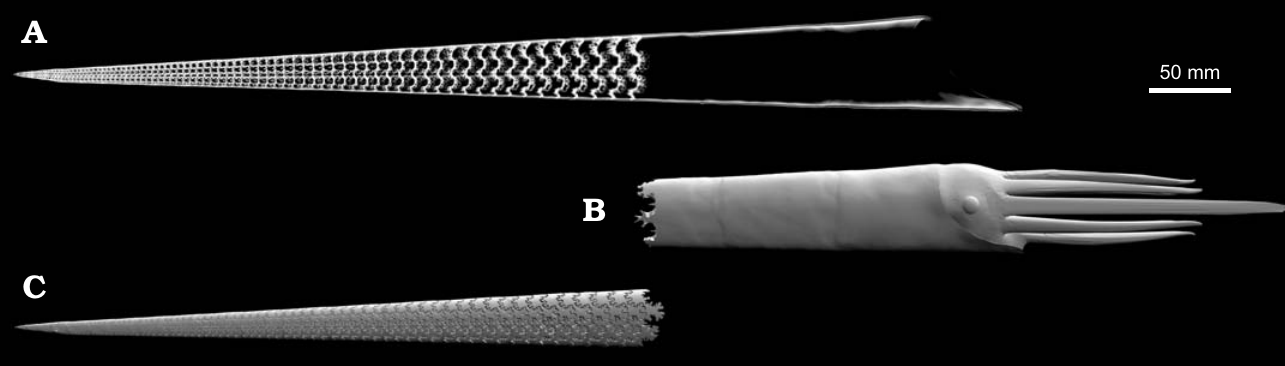
Fig. 3. Full 3D model of Baculites compressus with model components. A . Complete, digitally-reconstructed shell rendered in X-ray view to show internal structure. B . Three-dimensional model the soft body. C . Three-dimensional model of the cameral volumes within the